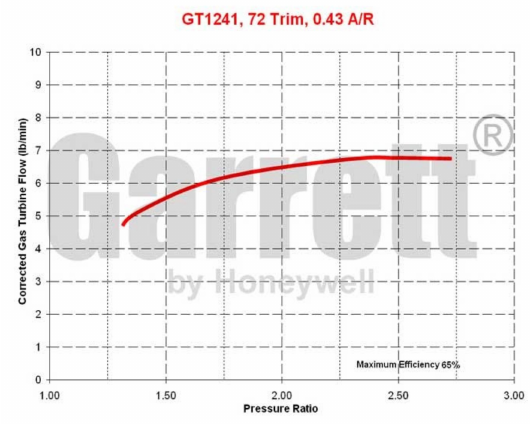
Figure 4. Garrett GT1238 turbine map.